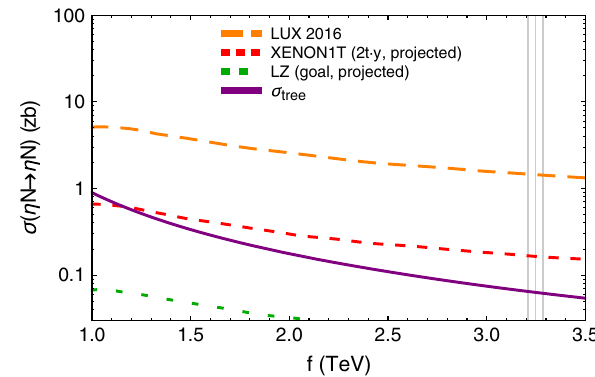
Fig. 6 Spin-independent direct detection cross section as a function of the compositeness scale, f , in the singlet DM case. We show the the- oretical estimate as a purple continuous line. We also show the current limits (linearly rescaled with the DM abundance) from LUX ( dashed orange ) [41] and the projected exclusion limits at 95% C.L. for LZ ( dashed green ) [42] and XENON1T of 2 years in 1 ton ( dashed red ) [43] λ H (cid:7) and from derivative operators like